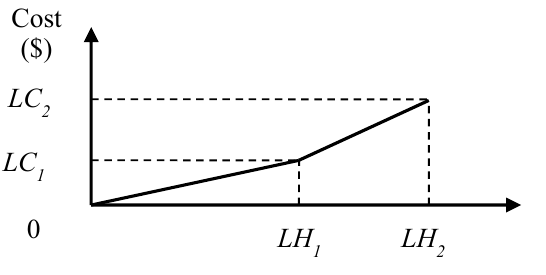
Figure 2. Piecewise direct labor cost.